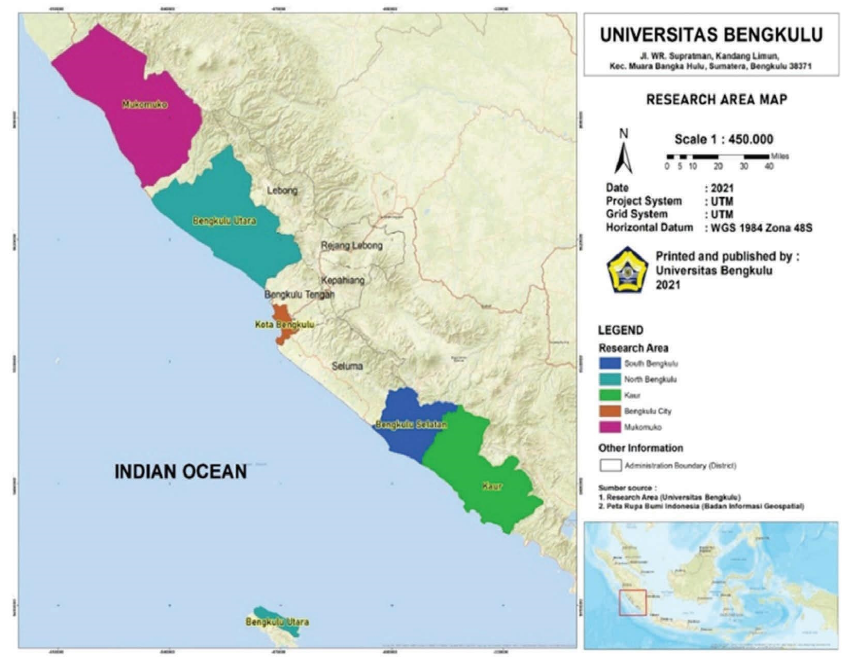
Figure 2: Research location processed by authors